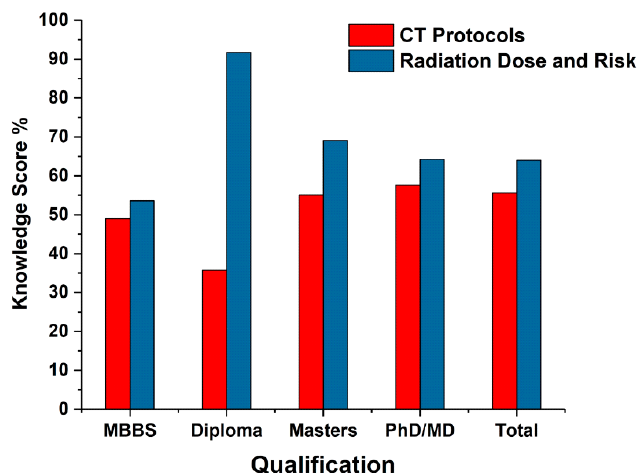
Figure 3. Comparison of participants ′ knowledge of CT protocol and radiation dose based on academic qualifications.